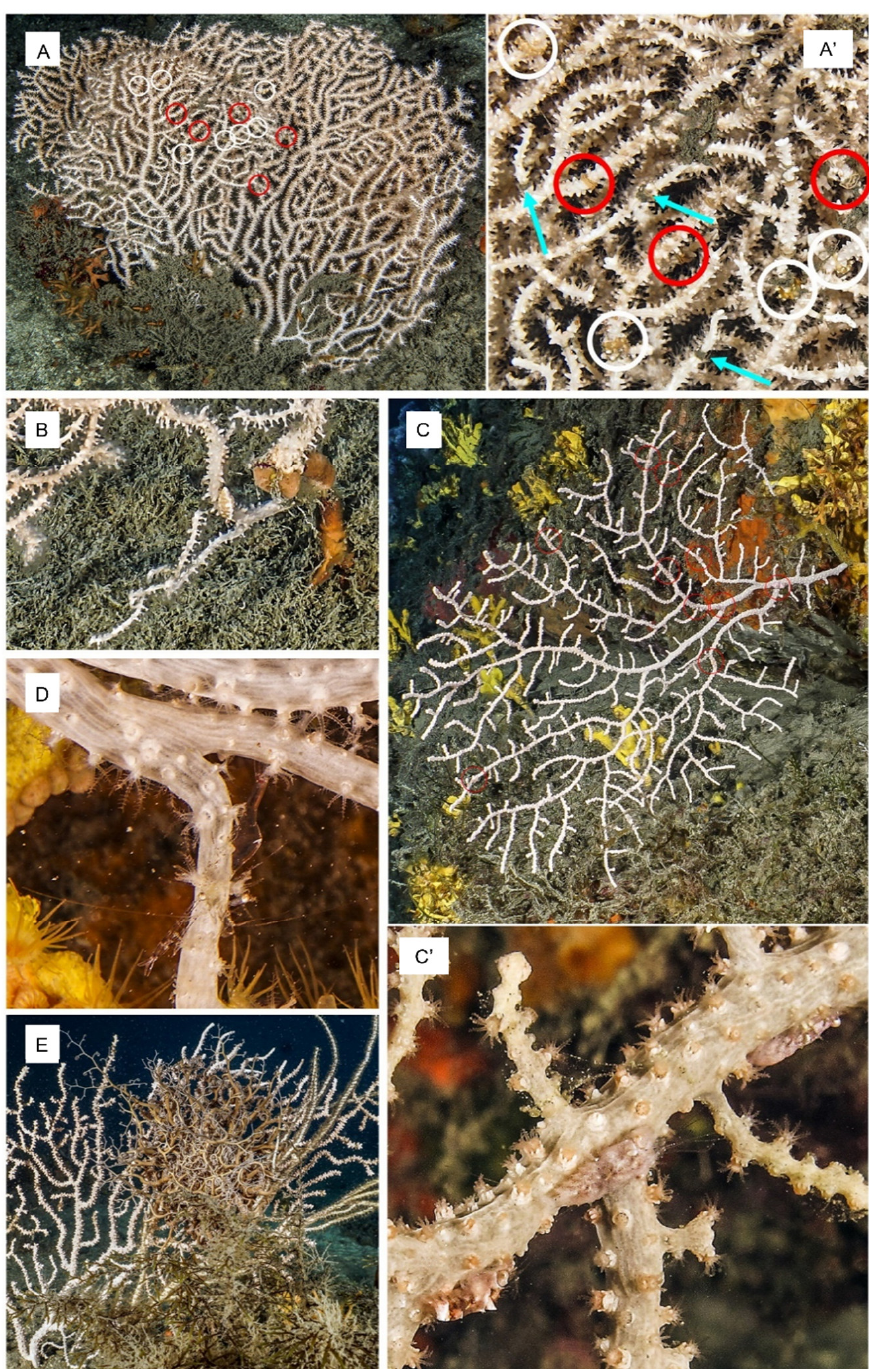
Figure 6. Associated vagile fauna with Eunicella verrucosa . The three predators, the nudibranch Duvaucelia odhneri (red circles) ( A ) together with its eggs (white circles) and damaged zones (blue arrows), ( A’ ) the ovulid Simnia spelta (red arrow), ( B ) and the decapod Balssia gasti , ( C , C’ ) the decapod Periclimenes scriptus, ( D ) the large acrophilic ophiuroid and ( E ) Astrospartus mediterraneous .